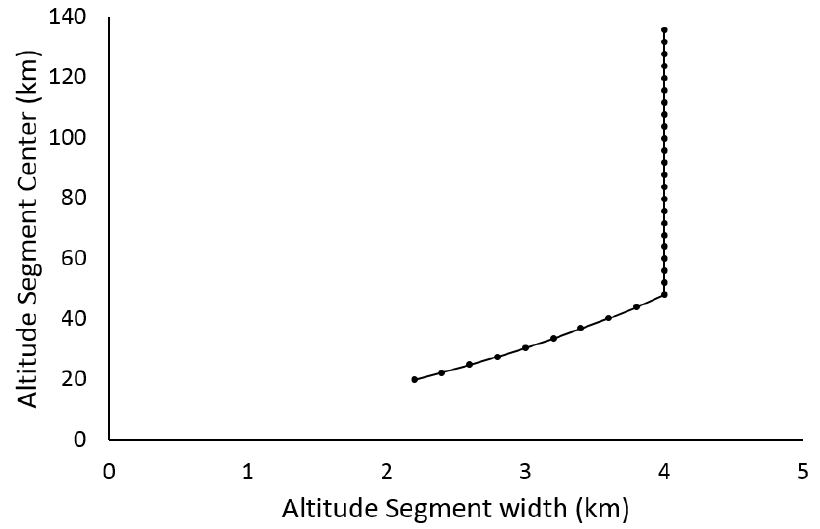
Figure 1. Altitude segments employed in generating line-of-sight wind profiles from the ACE-FTS. Below 45 km, segment widths become smaller with decreasing altitude to track the typical compression of tangent height spacing in ACE-FTS measurements that results from atmospheric refraction.